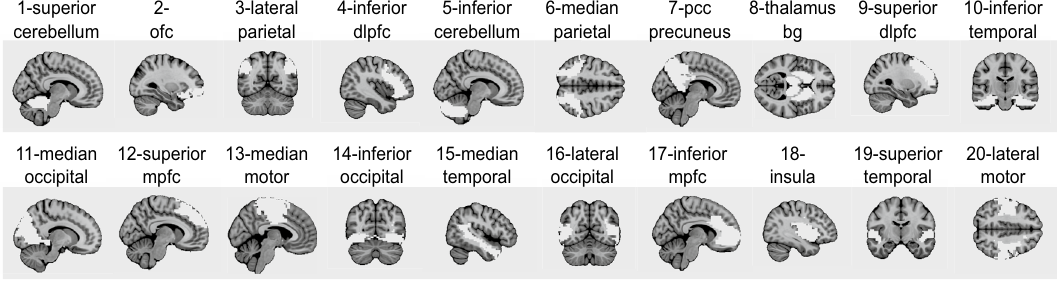
Figure 2. Brain parcellation into 20 clusters. This figure represents each of the 20 functional brain clusters in white on a select brain plane (see “Materials and methods” section). Names and numbers of clusters are as follows: 1—superior cerebellum; 2—orbitofrontal cortex (ofc); 3—lateral parietal cortex; 4—inferior dorsolateral prefrontal cortex (dlpfc); 5—inferior cerebellum; 6—median parietal cortex; 7—posterior cingulate cortex (pcc) and precuneus; 8—thalamus/basal ganglia; 9—superior dorsolateral prefrontal cortex (dlpfc); 10—inferior temporal cortex; 11—median occipital cortex; 12—superior median prefrontal cortex; 13—median motor cortex; 14—inferior occipital cortex; 15—median temporal cortex; 16—lateral occipital cortex; 17—inferior median prefrontal cortex (mpfc); 18—insular cortex; 19—superior temporal cortex; 20—lateral motor